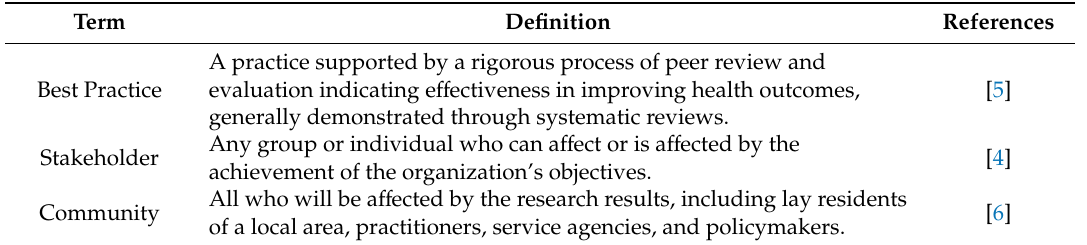
Table 1. Best practice concepts. This table defines concepts used in the